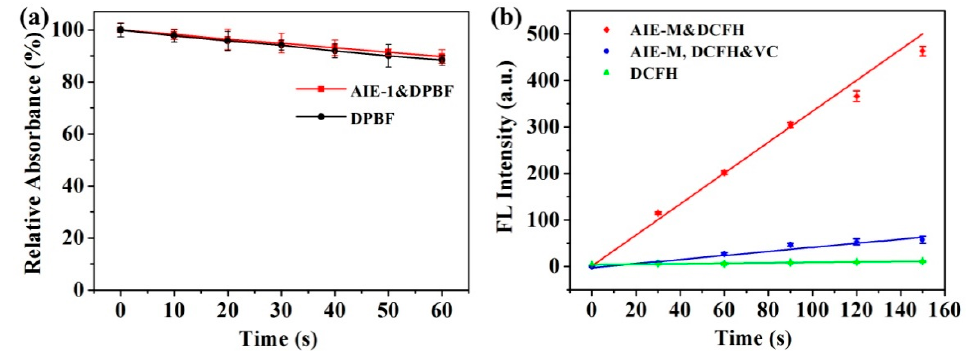
Figure 4. ( a ) The absorption changes at 418 nm of 1,3-diphenylisobenzofuran (DPBF) in DMSO and the mixed solution of DPBF and AIE-1 (10 μ M) with 365nm light irradiation; ( b ) The FL intensity changes of Dichlorofluorescein (DCFH) solution and the mixture of DCFH and AIE-M (10 μ M) in phosphate buffered saline (PBS) in the absence and presence of vitamin C (VC) after different time irradiation. The data are the mean values and standard deviations, n = 3.